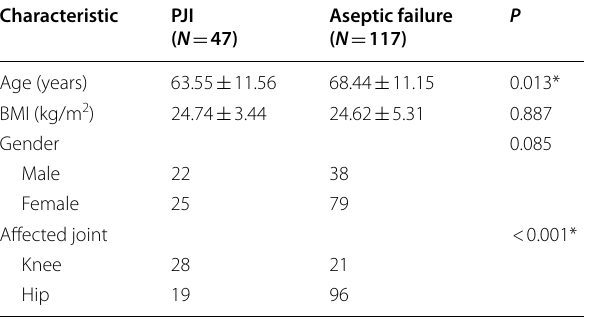
Table 2 Basic characteristics and biomarkers in the PJI and aseptic failure groups